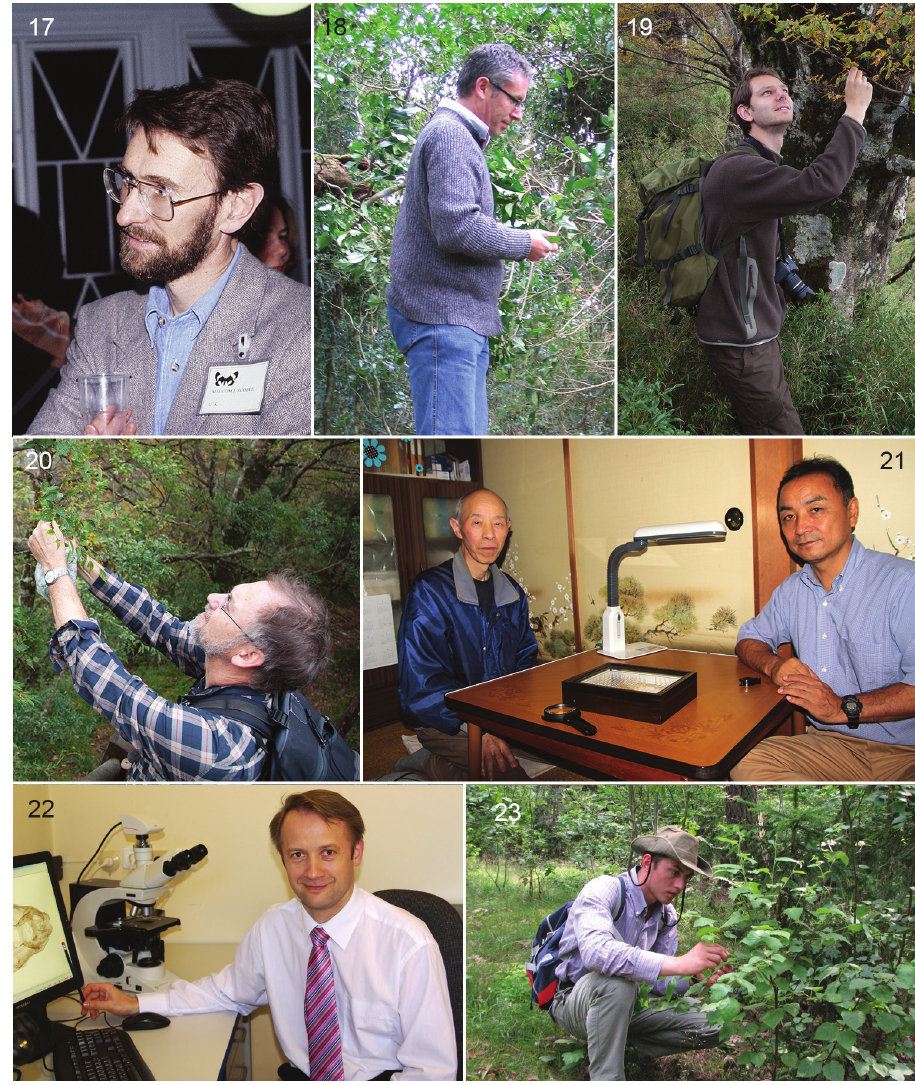
Figures 17–23. Specialists on Nepticuloidea in 20 th and 21 st century. 17 Malcolm Scoble, April 1992, Helsinki, Congress SEL 18 Robert J. B. Hoare, collecting Menurella quintiniae at type locality, Laming- ton Park, Queensland, August 2004 19, 20 Camiel Doorenweerd and Erik J. van Nieukerken collect- ing leafminers on Fagus hayatae , Taiwan, Taipingshan, October 2012 21 Nagao Hirano and Toshiya